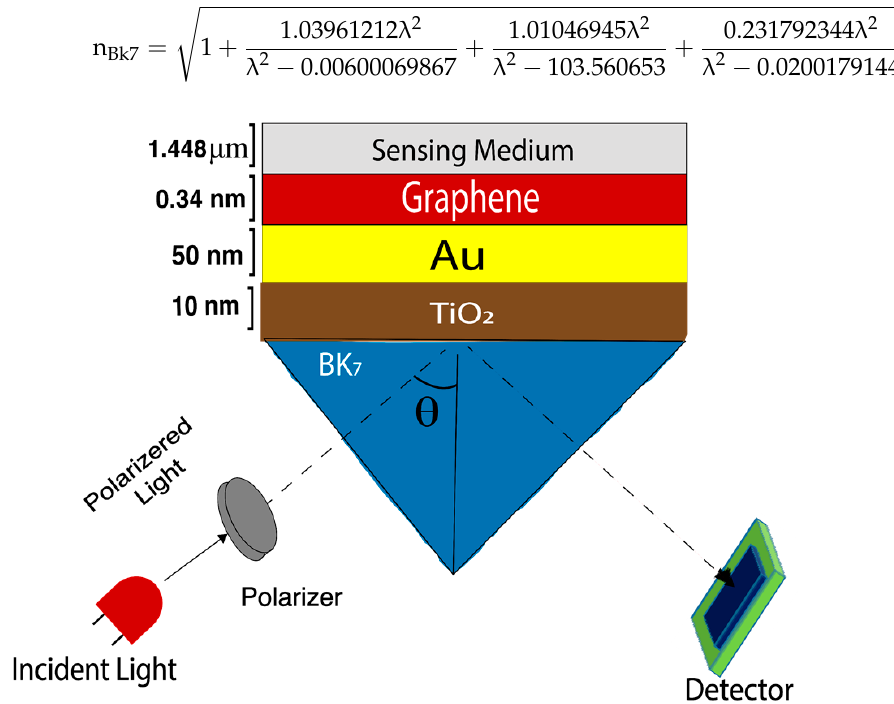
Figure 1. Structural arrangement for BK 7 /TiO 2 /Au/graphene-based heterostructure biosensor. Table 1. Proposed sensor structural design parameter at the wavelength of 633 nm. Layer